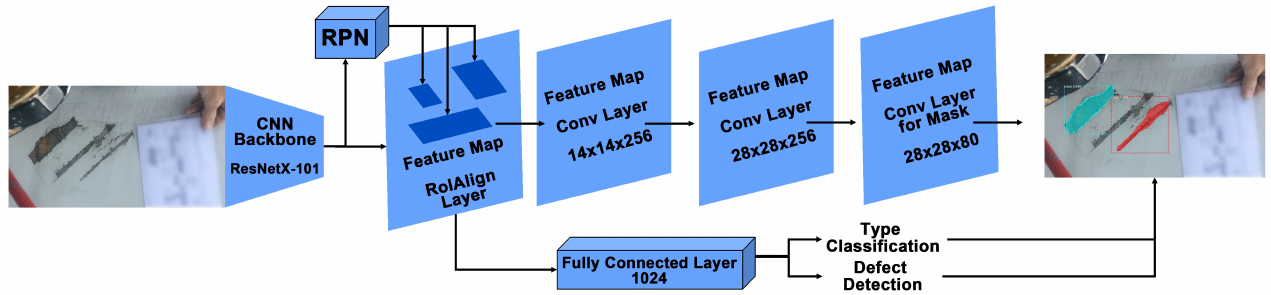
Figure 6. Mask R-CNN architecture with ResNetX-101 backbone and Fully Connected layers (FC layers). This architecture was embedded in the proposed IE Mask R-CNN